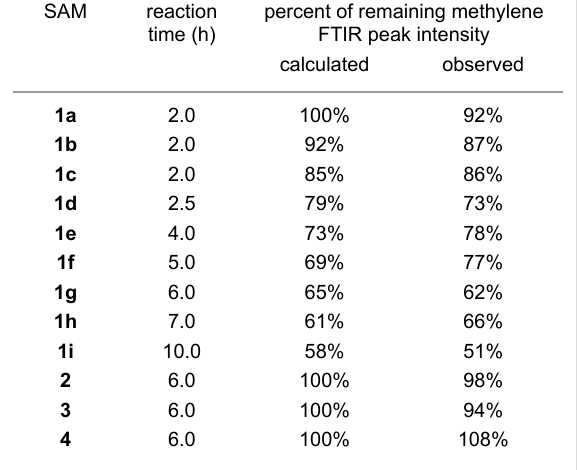
Table 2: Reaction times and methylene loss (based on ATR–FTIR integration) for OXONE oxidation of SAMs of compounds 1 – 4 ; all surfaces became highly hydrophilic (water contact angles